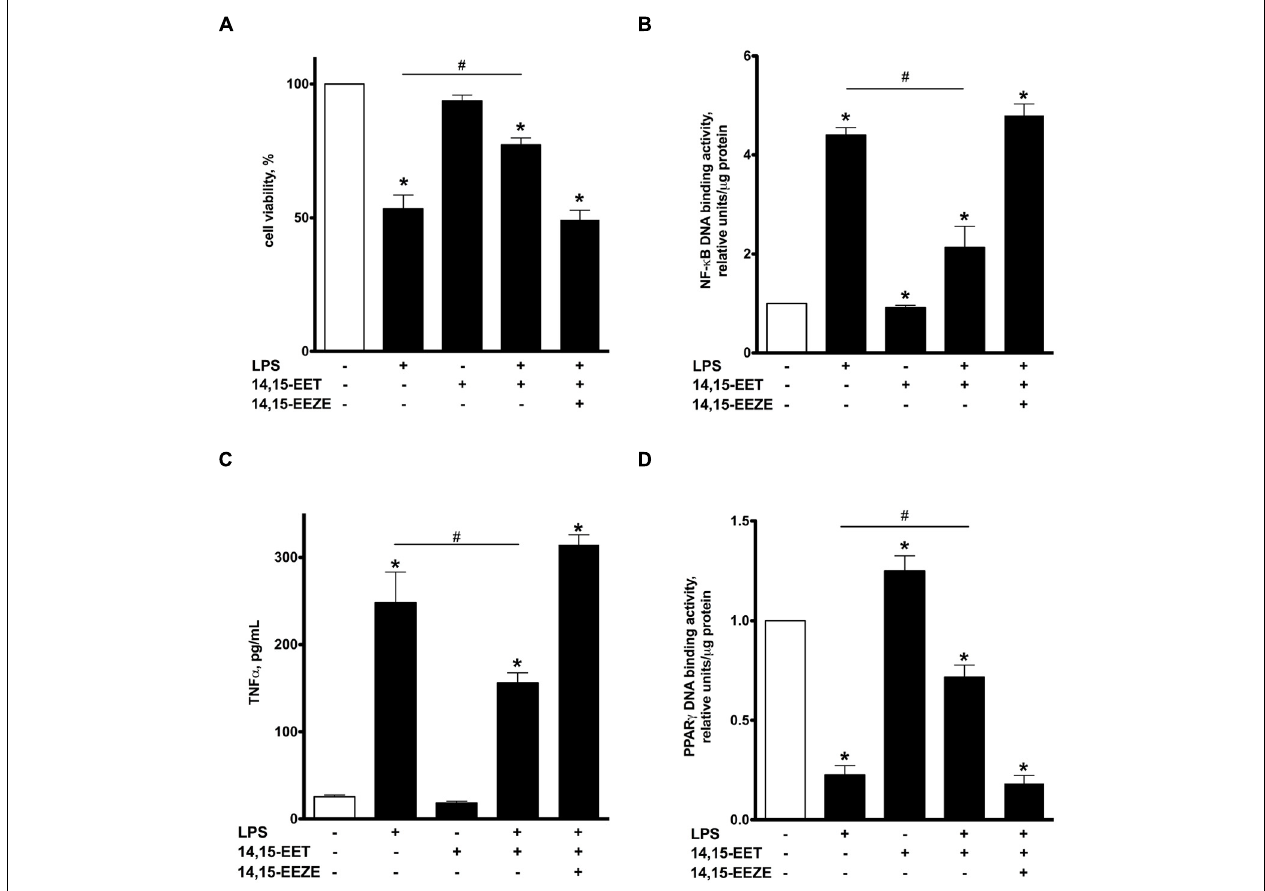
as seen with reductions in NF-kB DNA binding activity and TNF α release. (D) 14,15-EET induced an increase in PPAR γ DNA binding activity and significantly prevented LPS-triggered drop in PPAR γ DNA binding activity. Values are represented as mean ± SEM, N = 3–4. Significance was set at P < 0.05. * Significantly different from control. # Significantly different from LPS-treated